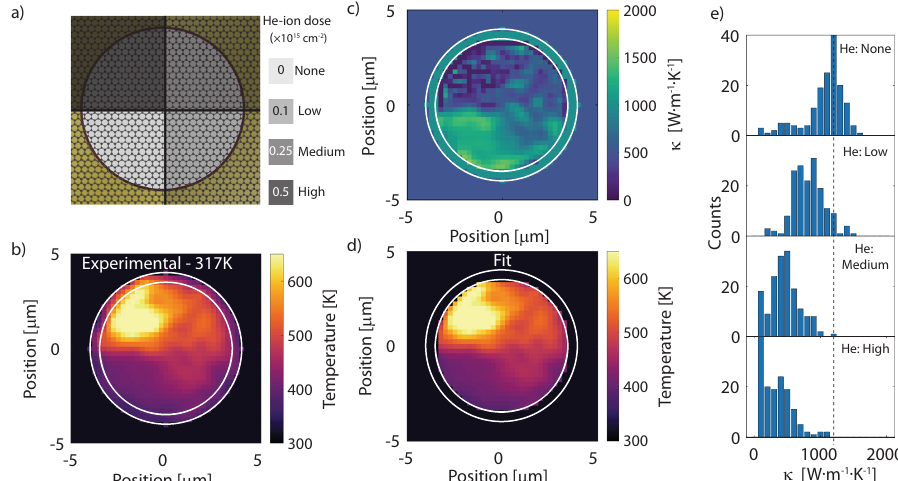
Fig. 5 Thermal conductivity of defect-engineered graphene. a Schematic image of a suspended graphene membrane. The areas where the membrane was exposed to He + -ions and their corresponding dose is indicated with different colors. b Experimentally observed temperature map. c Fitted thermal conductivity map. d Fitted temperature map. e Histogram of the thermal conductivity for various defect